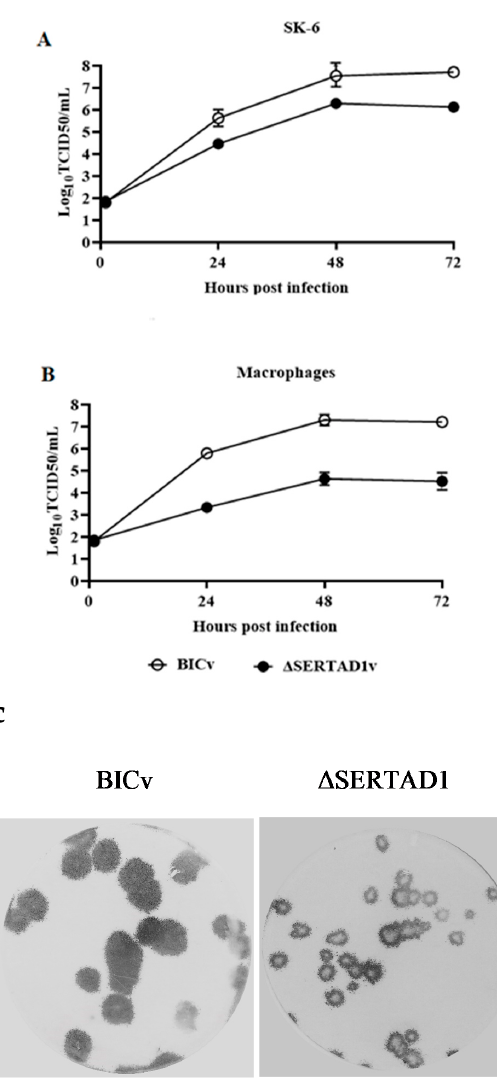
Figure 3. The in vitro growth characteristics of CSFV E2 Δ SERTAD1v. The multistep growth curves of E2 Δ SERTAD1v and BICv in ( A ) SK6 cells and ( B ) swine macrophage cell cultures. Cell cultures were infected (MOI of 0.01) with CSFV BICv (empty symbols) or E2 Δ SERTAD1v (filled symbols). At the indicated times post-infection, samples were collected and titrated for virus yield. Data are represented as the means and standard deviation of three independent experiments. ( C ) Plaque formation of CSFV E2 Δ SERTAD1v and BICv on SK6 cell cultures. Cell cultures were infected with either virus and stained 4 days later as described in Materials and Methods.